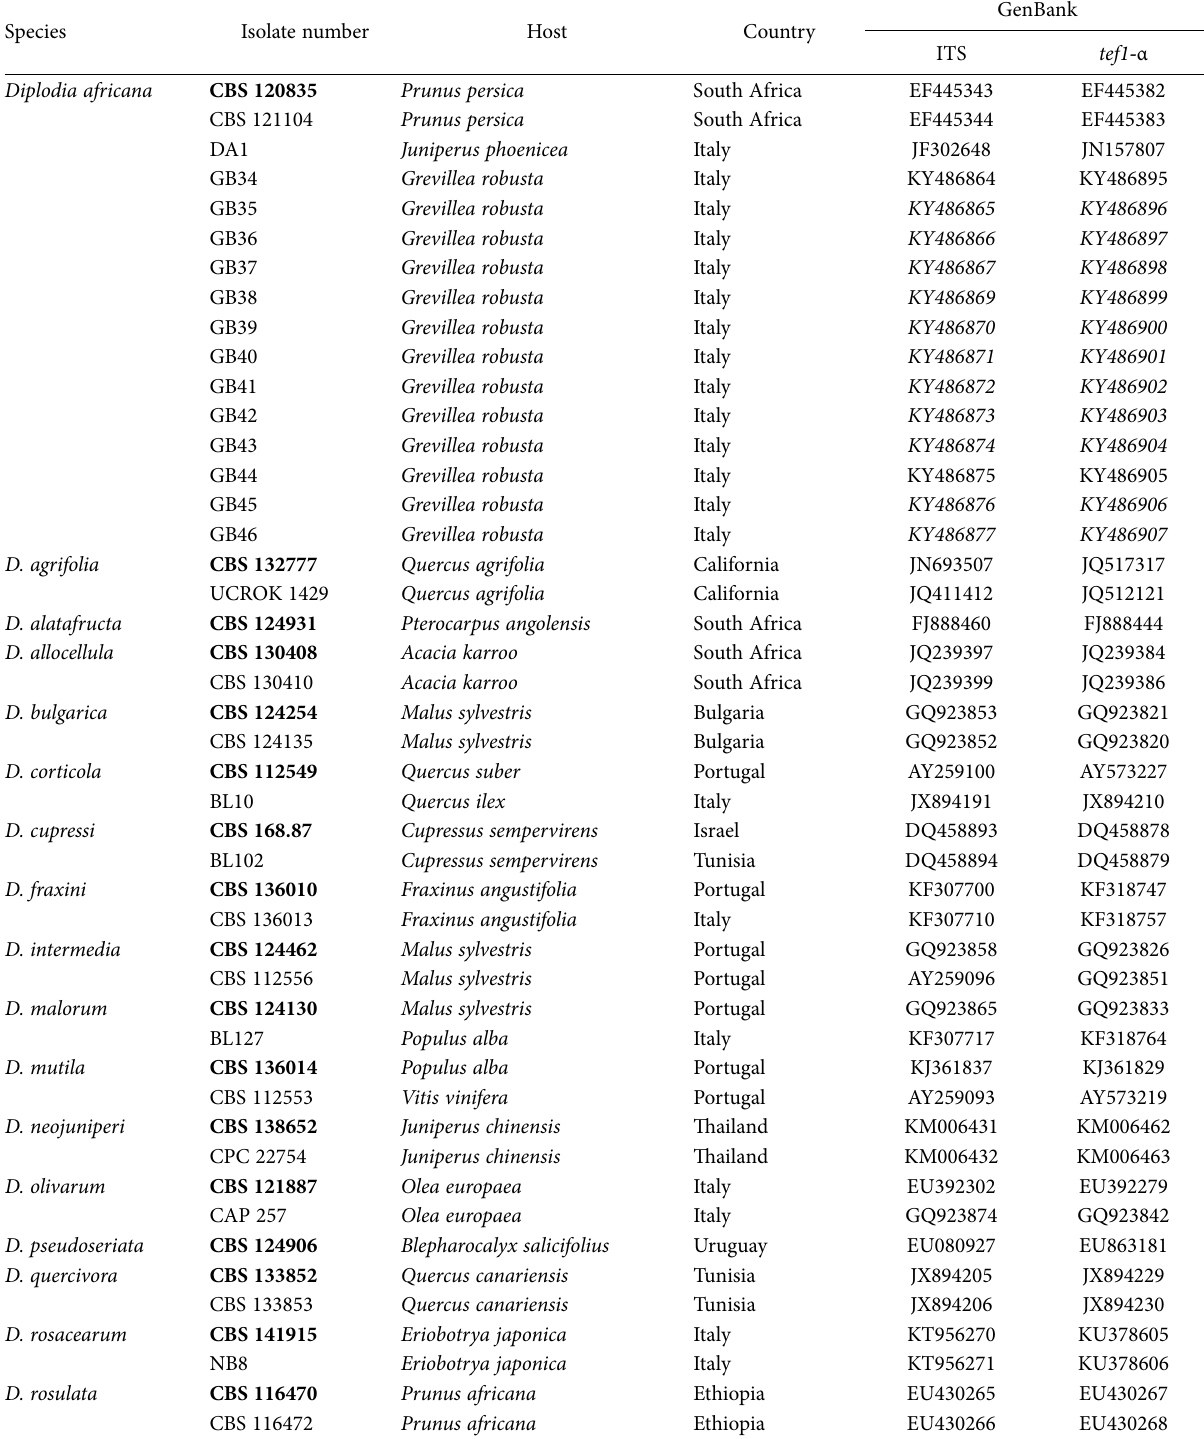
Table 1. Isolates included in the phylogenetic study. The newly generated sequences are indicated in italics and ex-type strains are indicated in bold